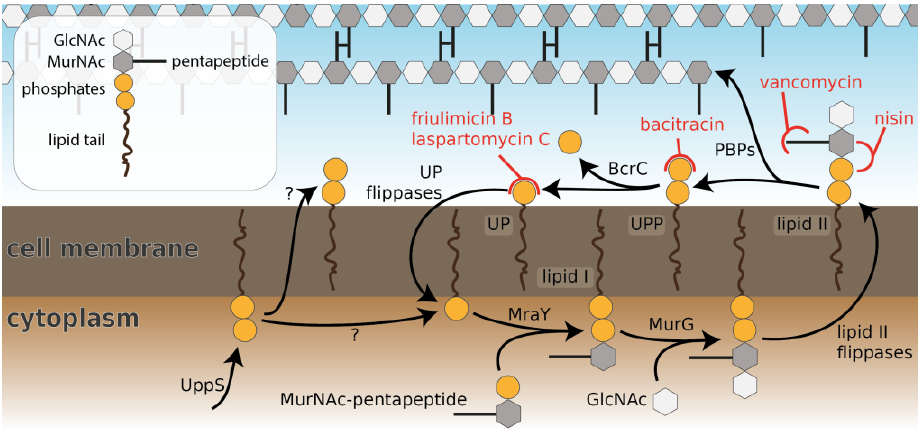
Figure 1. Schematic overview of the lipid II cycle of Bacillus subtilis , including lipid carrier molecules, involved enzymes and selected antibiotics that target cell wall synthesis. The cell wall precursor lipid II is assembled on the cytoplasmic side of the membrane and then flipped. After insertion of the GlcNAc-MurNAc pentapeptide into the growing peptidoglycan, the lipid carrier UPP is recycled via dephosphorylation by BcrC. The generated lipid carrier UP is subsequently flipped back to the cytoplasmic side of the membrane to begin a new cycle. The lipid carrier is supplied by UppS in the form of UPP on the cytoplasmic side of the membrane; it remains to be elucidated whether newly synthesized UPP is fed into the cycle by dephosphorylation on the cytoplasmic side of the membrane or by flipping. Example antibiotics that target lipid carrier pools on the periplasmic side of the membrane are indicated in red.